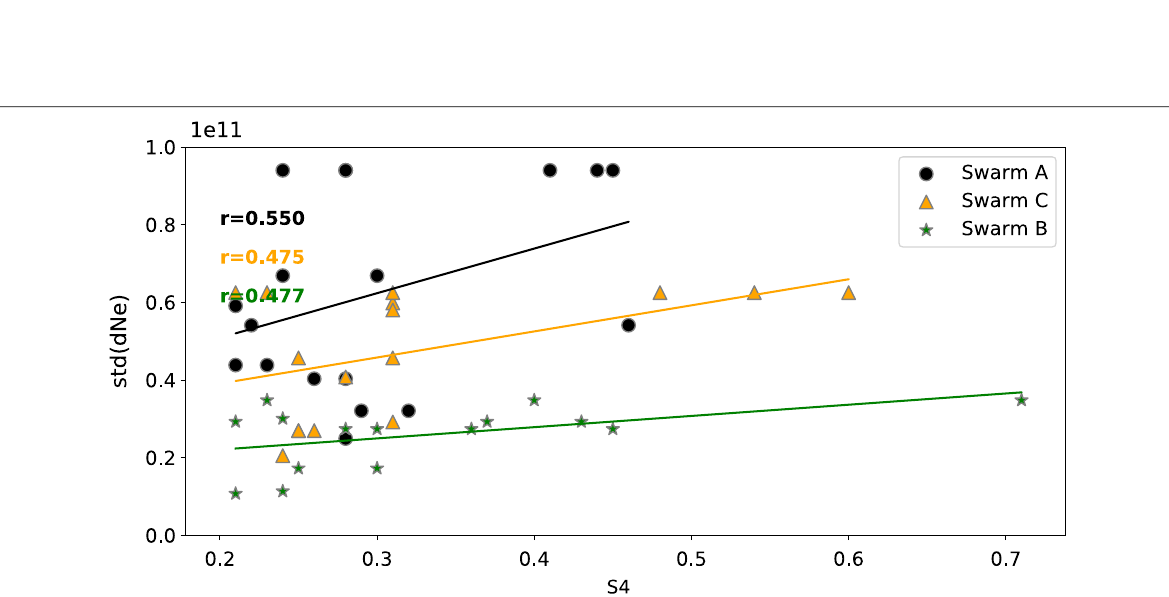
Fig. 8 Relation between the GPS-SCINDA scintillation intensity and Swarm N e perturbations for the years from 2014 to